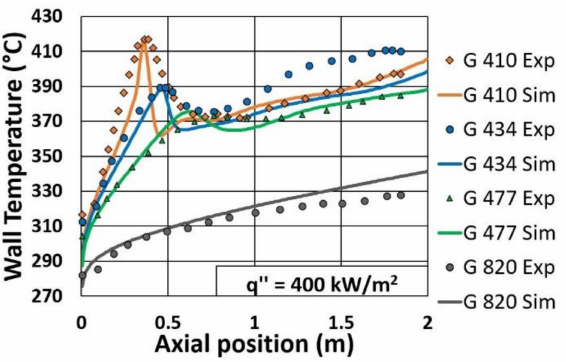
Figure 9. Selected CFD results for Watts’ data at T in = 250 ◦ C and 400 kW/m 2 .